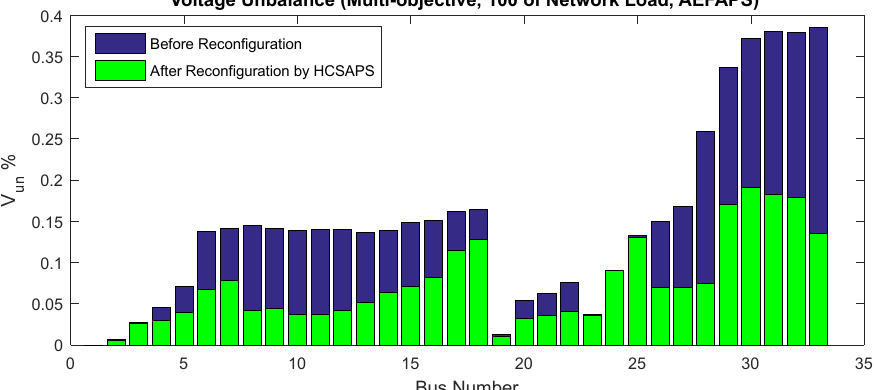
Figure 11. Voltage unbalances for an unbalanced 33-bus network via AEFAPS before and after reconfiguration (nominal load).